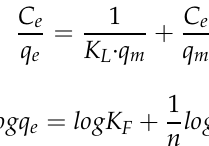
Table 1. Langmuir and Freundlich isotherm model concerning the adsorption of Cr(VI) and Cu(II) by Fe 3 O 4.